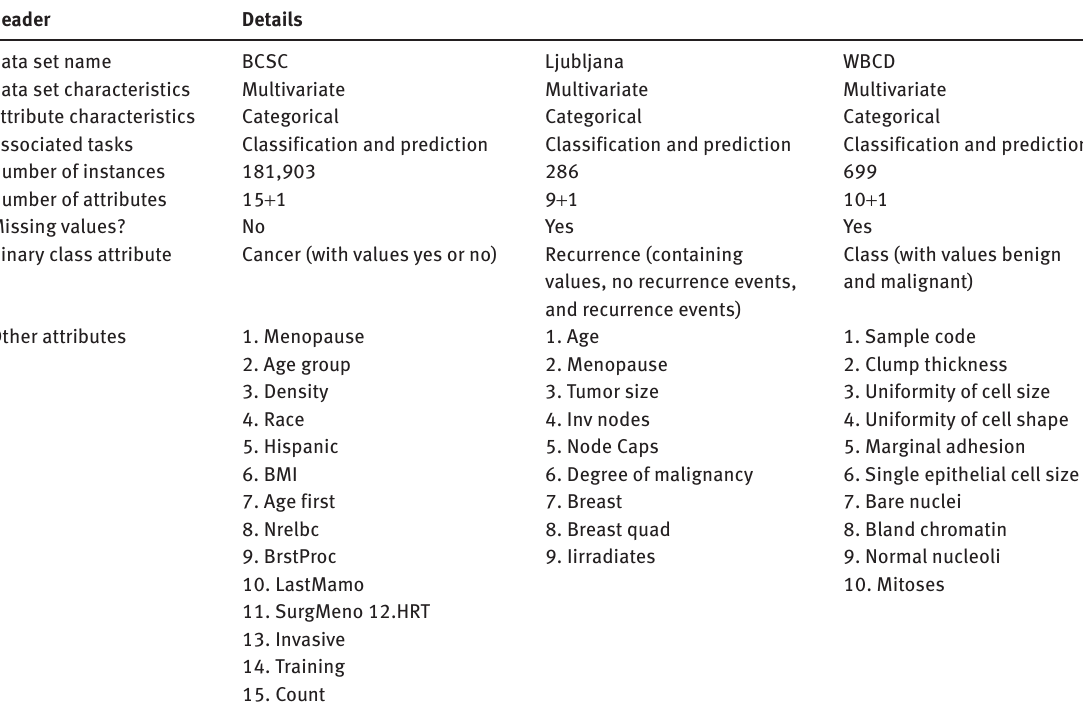
Table 1: Details of Various Breast Cancer Data Sets Used for Feature Selection. Header